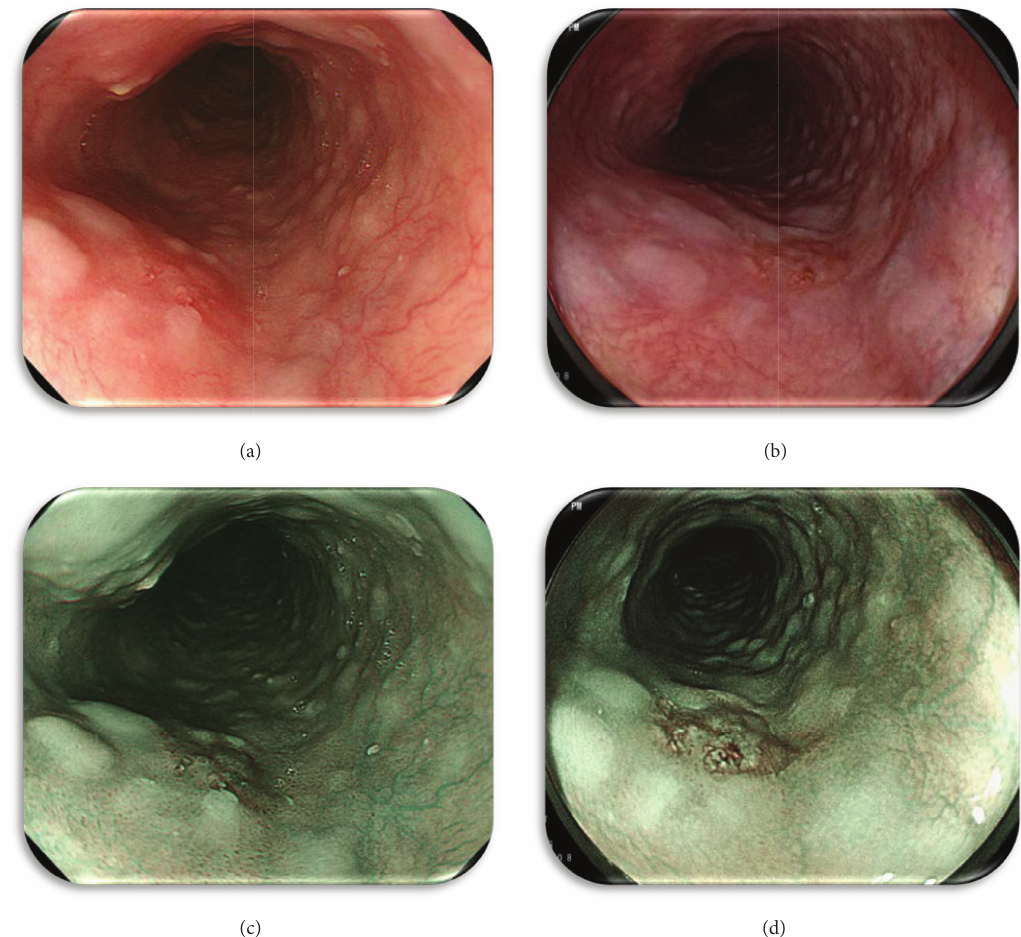
Figure 1: Representative still images: superficial flat depressed lesion (0-IIc type) on the middle thoracic esophagus. (a) O-WLI image, (b) F-WLI image, (c) NBI image, and (d) BLI-bright